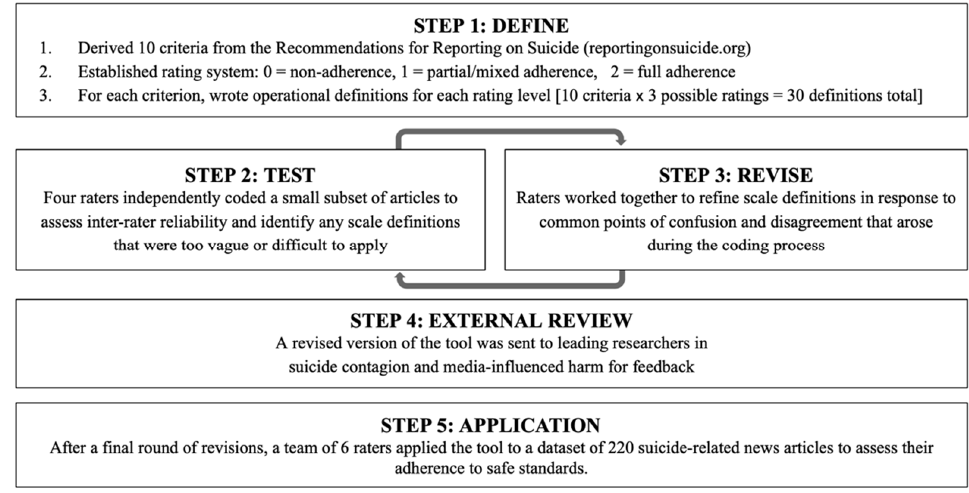
Figure 1. TEMPOS Development Process.